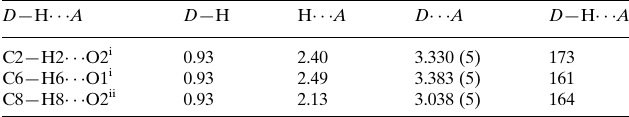
Hydrogen-bond geometry (A˚ , (cid:3)